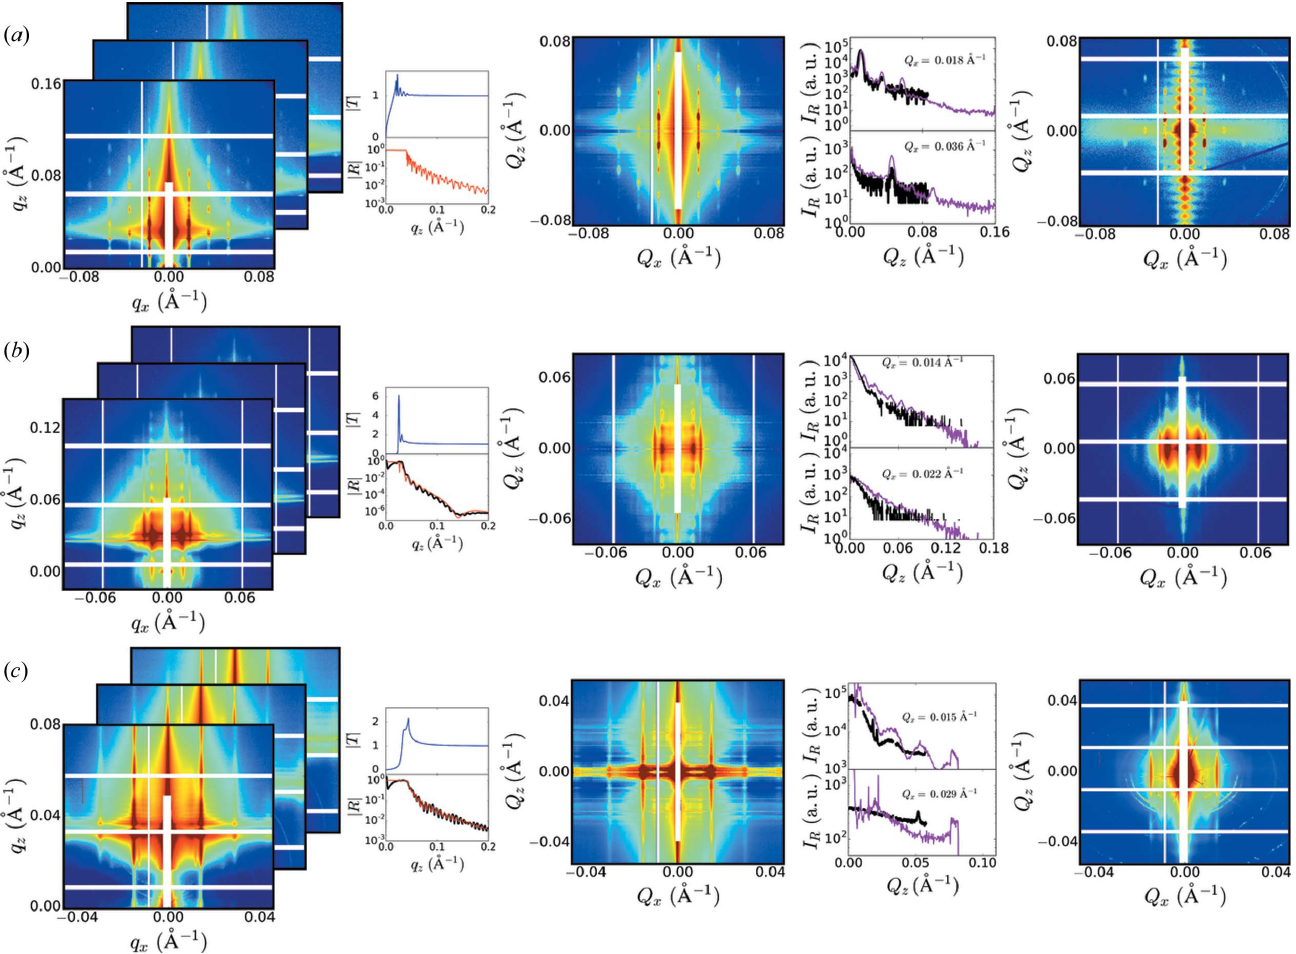
Figure 5 Example reconstructions based on experimental GISAXS data. Each row shows (from left to right) the set of GISAXS images, the transmission and reflectivity curves (model curves in blue/red; experimentally measured reflectivity in black), the reciprocal-space reconstruction ½ I through the reconstruction (reconstruction in purple, GTSAXS data in black) and the experimental GTSAXS image. The presented data are ( a ) a self- assembled phase of horizontally oriented cylinders that form a hexagonal lattice, ( b ) multilayered block-copolymer nanostructures and ( c ) an in-plane array of inorganic